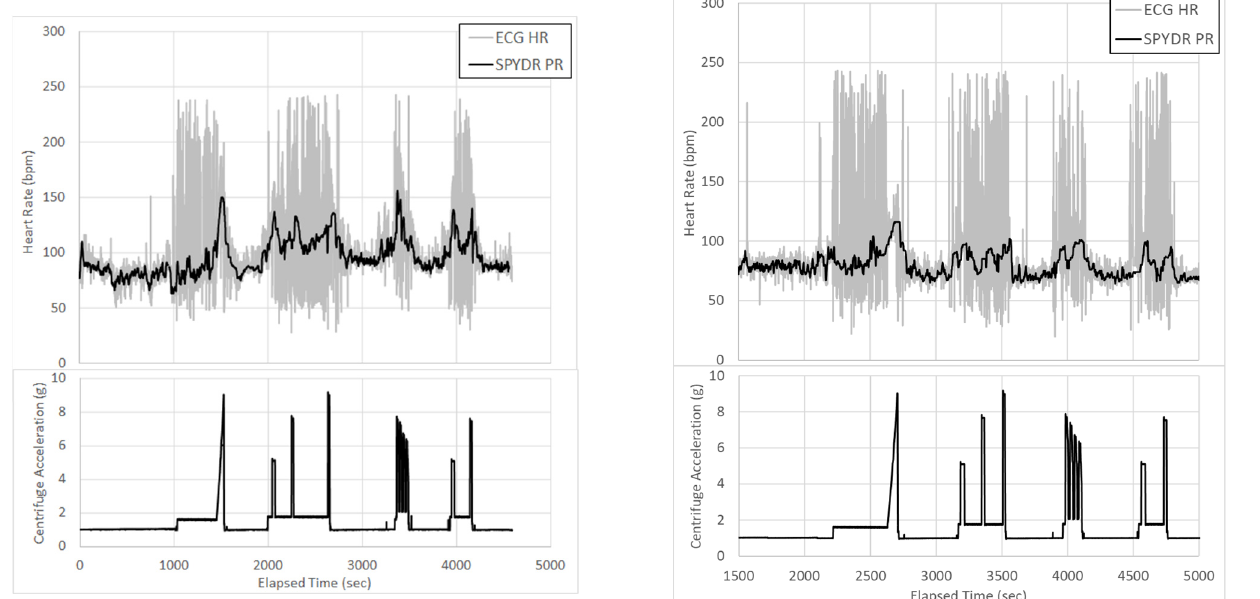
Figure 5. Centrifuge testing of heart rate as determined by electrocardiogram of a test subject in a manned centrifuge simulating high-acceleration flight. ECG was highly unreliable and mostly unusable, especially during periods of motion and acceleration.